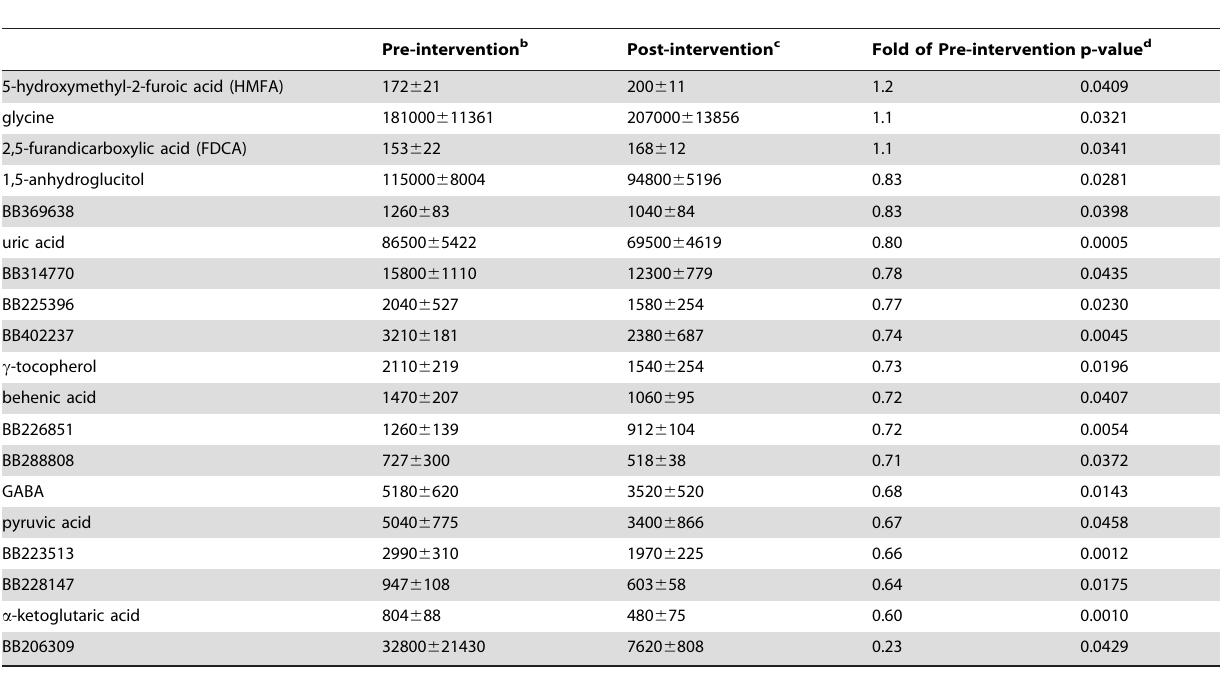
Table 2. Overnight-fasted concentrations of identified and as-yet unidentified plasma metabolites a that were significantly altered by a weight loss and fitness intervention in adult